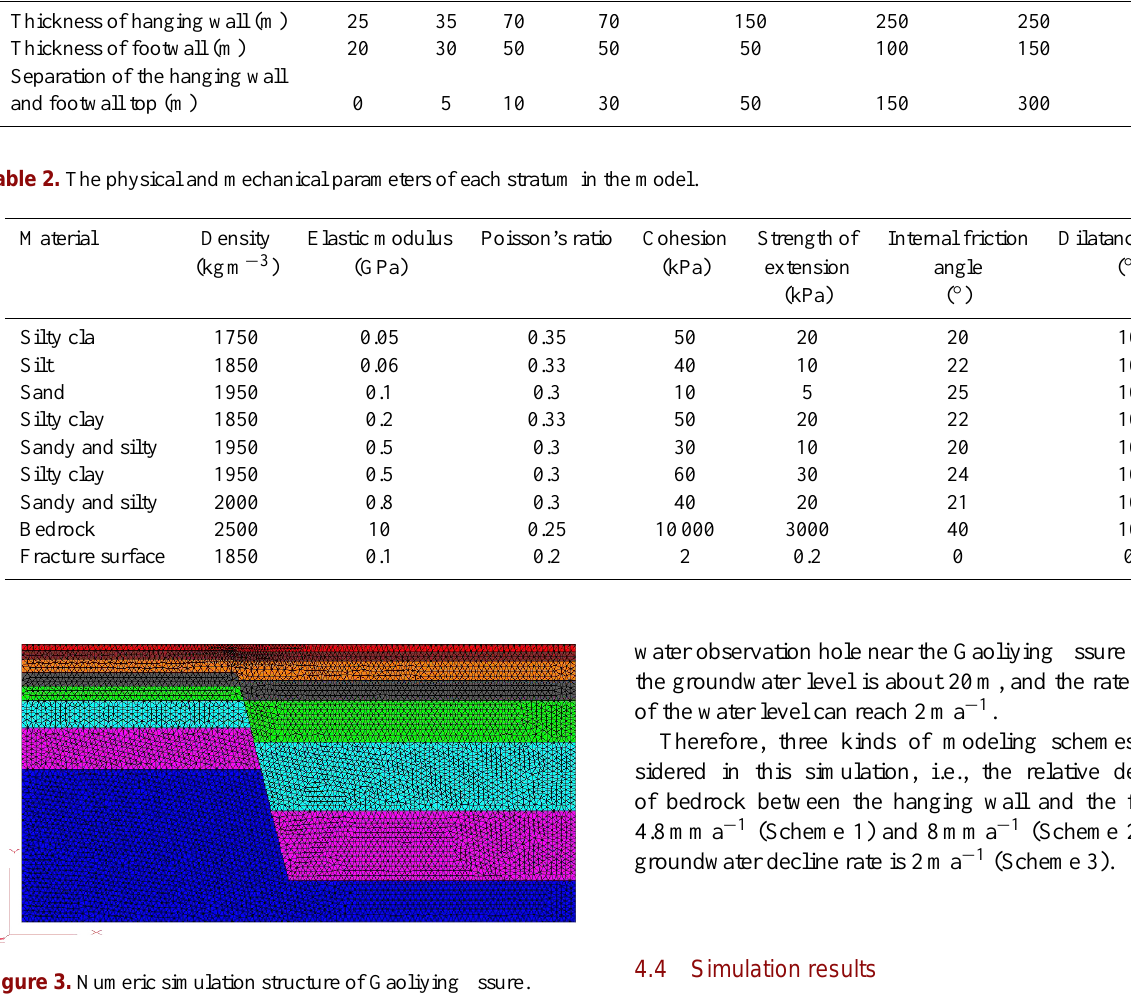
Figure 3. Numeric simulation structure of Gaoliying